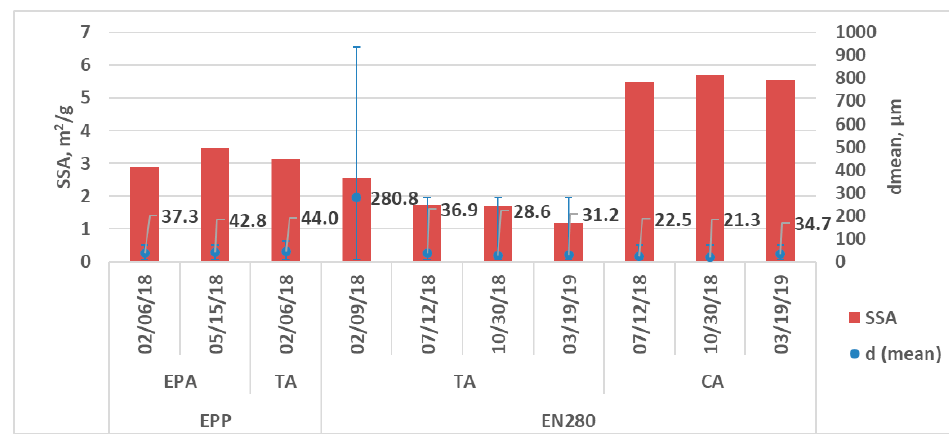
Figure 2. Particle size and BET SSA for APP (EPA, TA). Minerals 2020 , 10 , x FOR PEER REVIEW